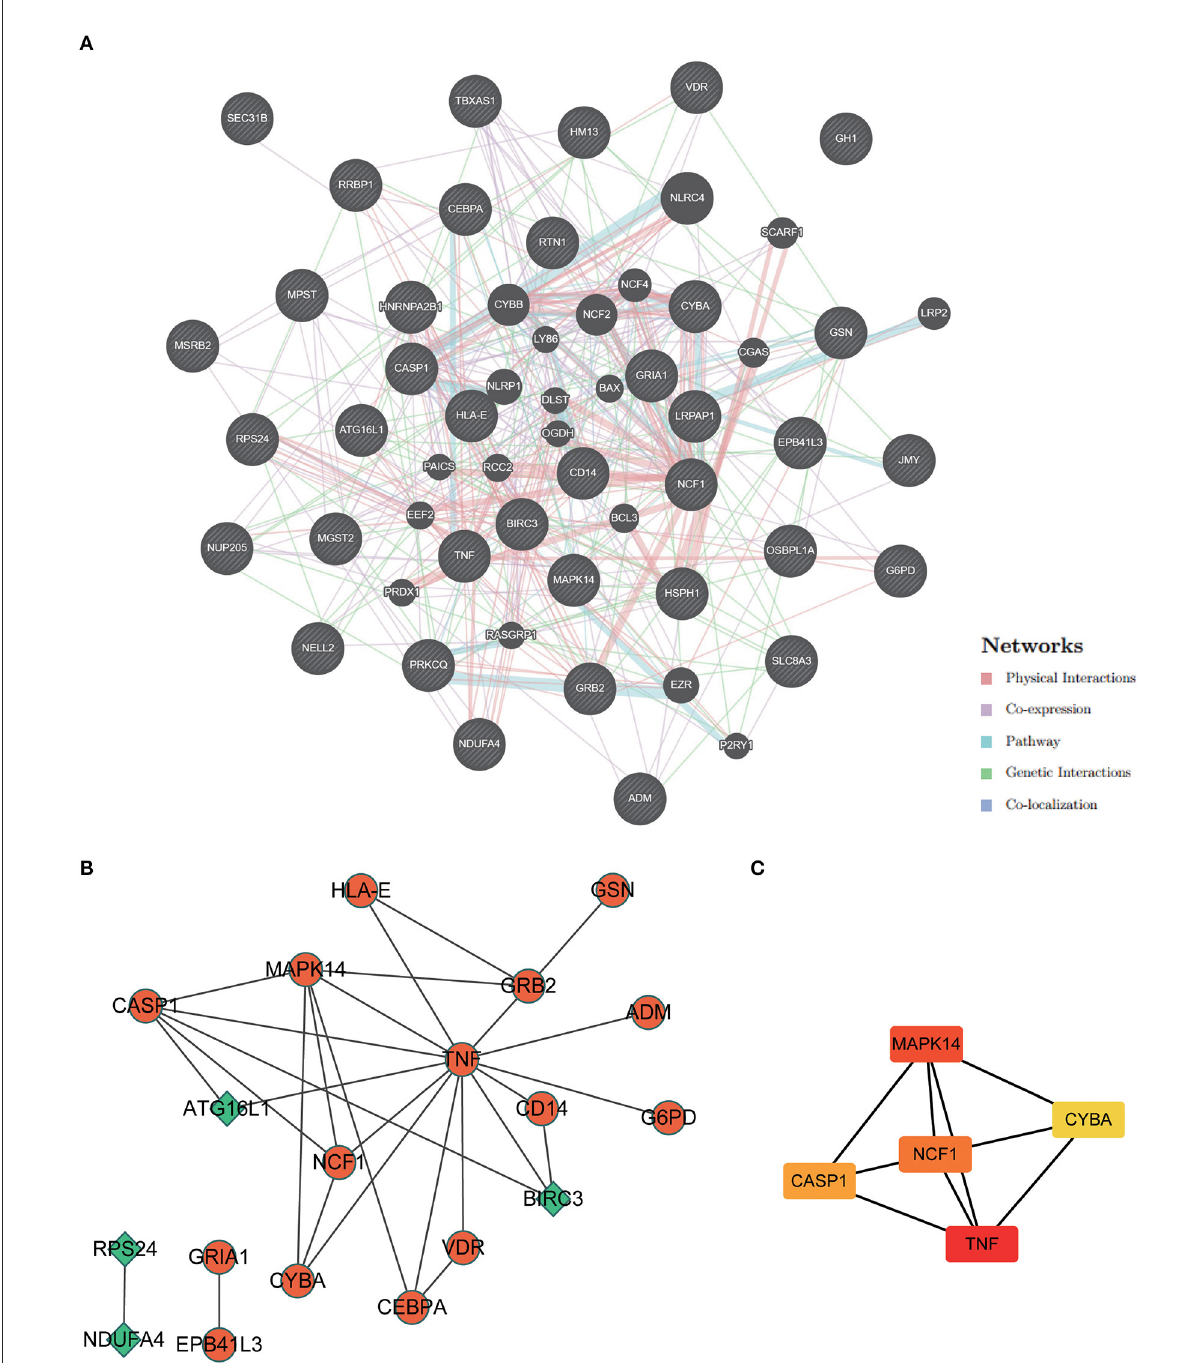
FIGURE9 Protein-protein interaction (PPI) network analysis and hub gene screening. (A) The Gene interaction network of ERSR-DEGs was constructed and visualized using geneMANIA. (B) PPI network of ERSR-DEGs was constructed using STRING and visualized in Cytoscape. Green or orange are gene expressions down or upregulated, respectively. (C) Top 5 hub genes screened by MCC of cytohubba. The deeper the color, the higher the MCC